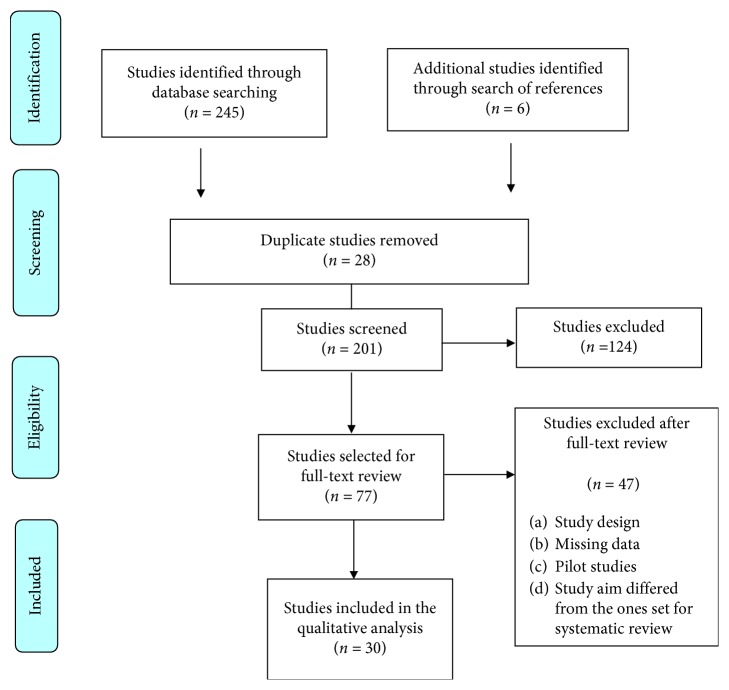
Flow chart for article selection.